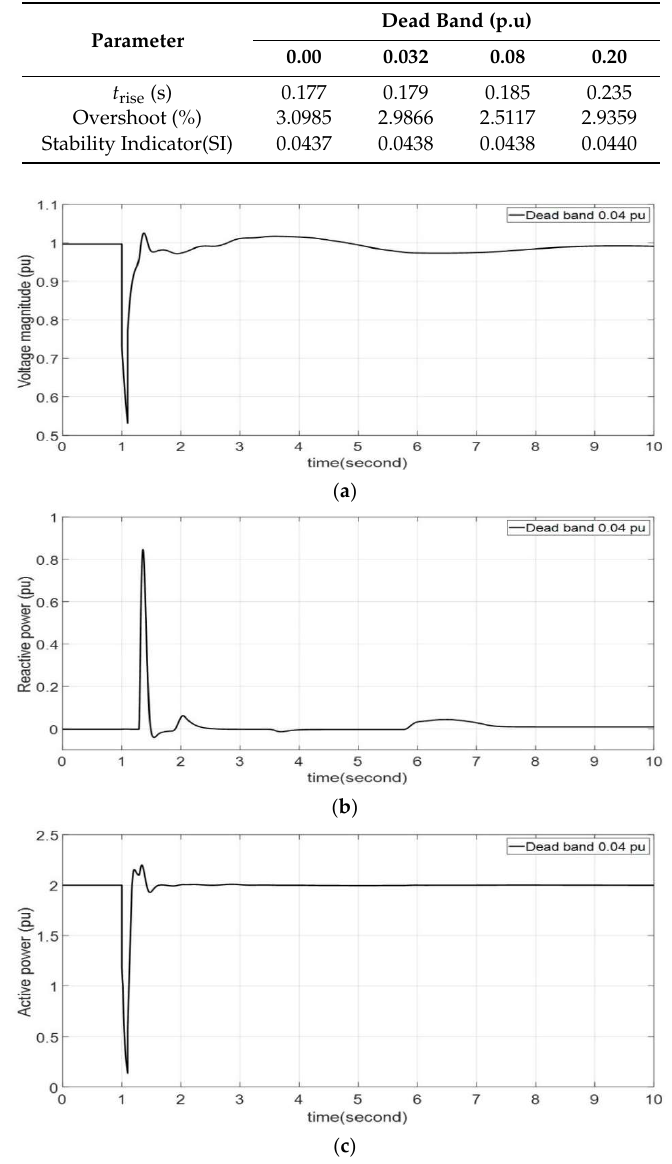
Figure 13. ( a ) Voltage profile, and ( b ) reactive and ( c ) active power result obtained by large